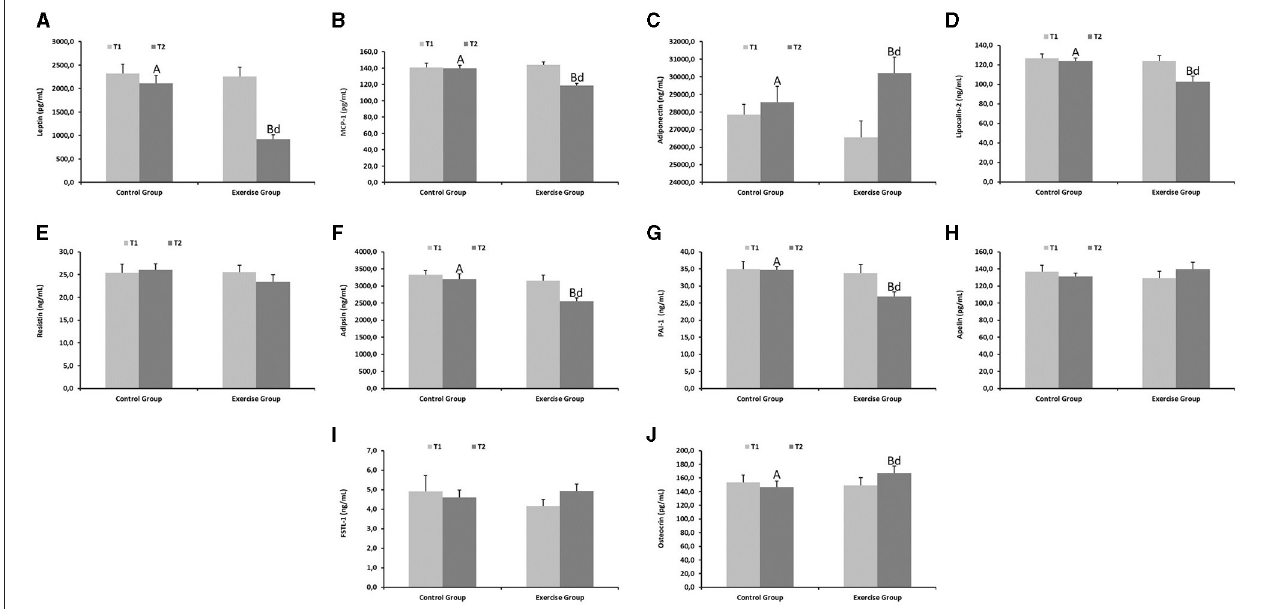
FIGURE 2 | Endocrine function parameters of the adipose tissue from the control and exercise groups. Mean values among groups with different letters differ ( P < 0.05) ( a,b for T1 and A,B for T2 by Student’s t test between different groups; d for T1 vs. T2 in the same group by Tukey’s test). (A) Leptin, (B) MCP-1, (C) Adiponectin,